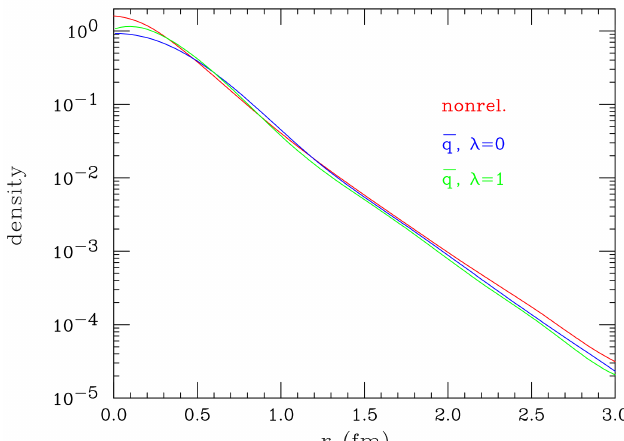
Figure 1. Densities obtained from G e ( q ) of [20] before (red) and after (blue, green) the application of the relativistic